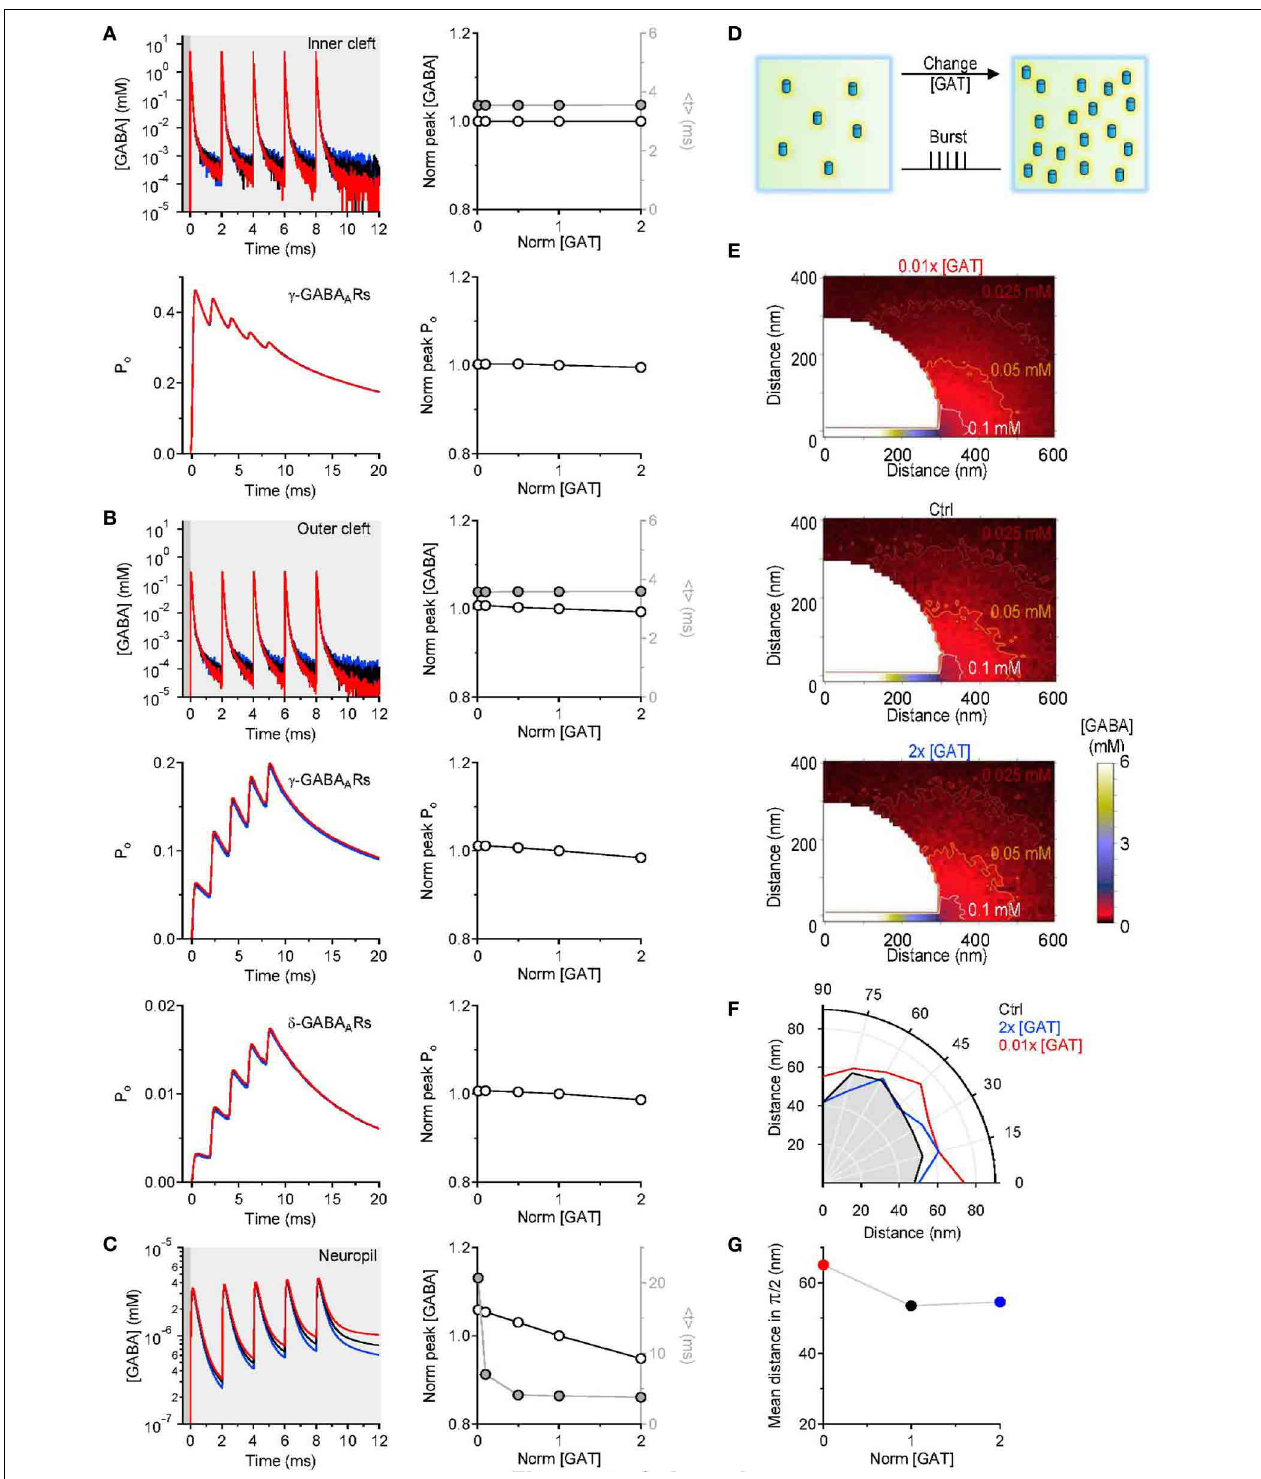
FIGURE 4 | Simulations results obtained with repeated GABA release events. (A) Five consecutive GABA release events, 2ms apart from each other, were simulated. The GABA concentration profile in the inner cleft volume was measured when varying the concentration of GABA transporters in the entire simulation environment (top left). The peak corresponded to the maximum GABA concentration evoked by the repeated stimuli and was